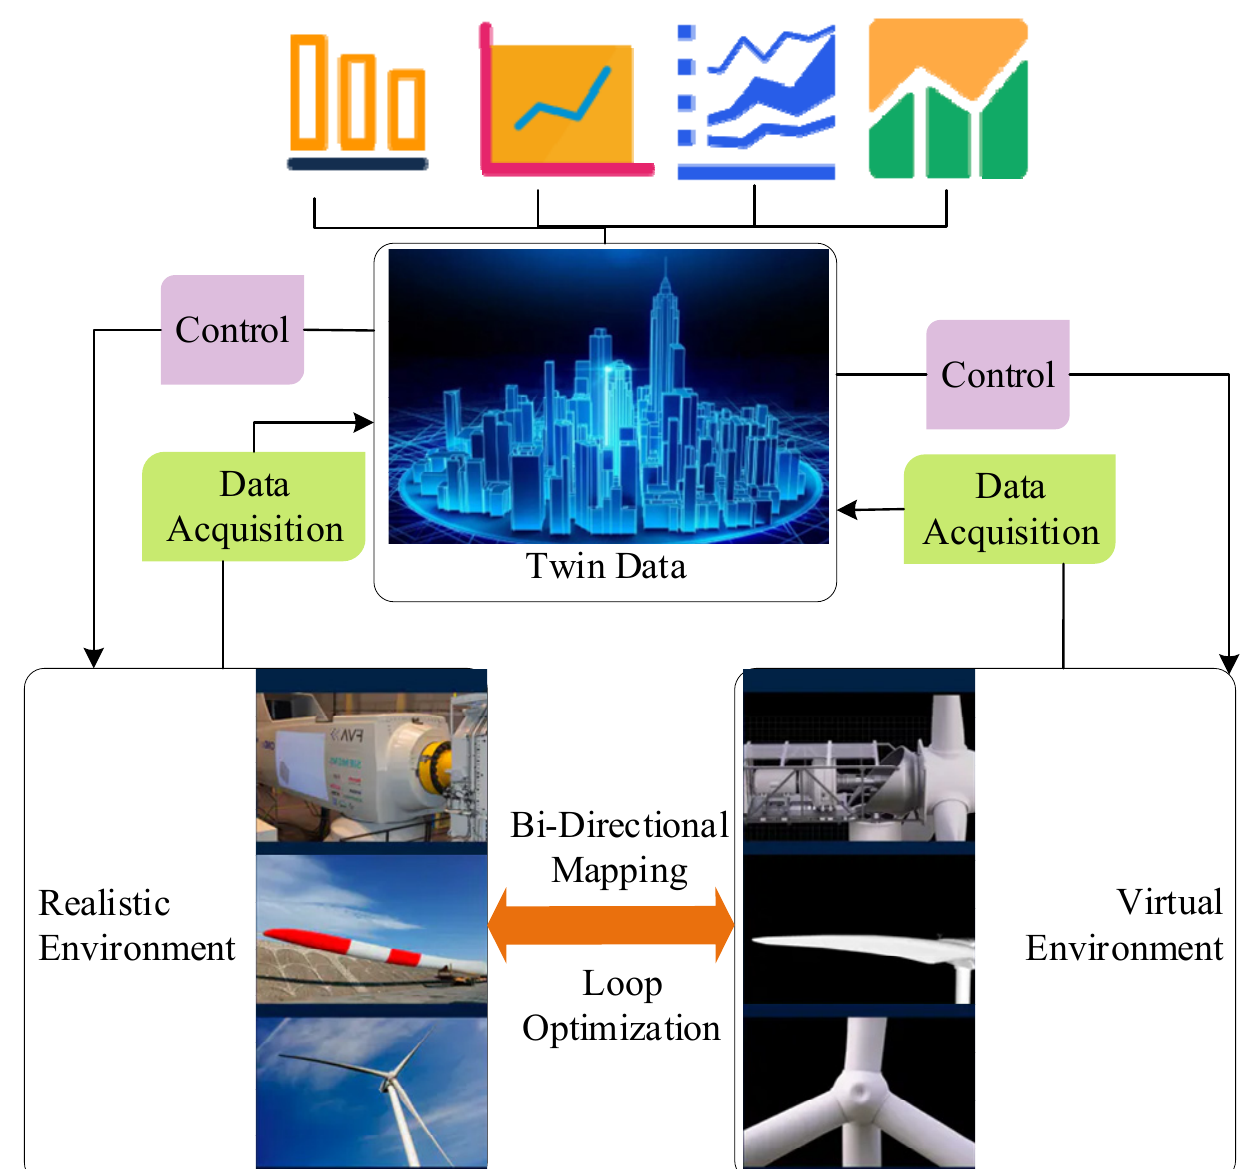
maturing simulation technology. Figure 2 exemplifies the simulation applications of DTT in four scenarios.